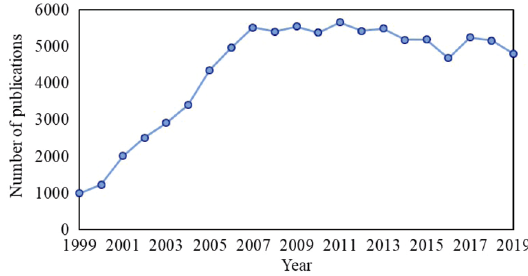
Fig. 1 Number of published papers about microfabrication over the last 20